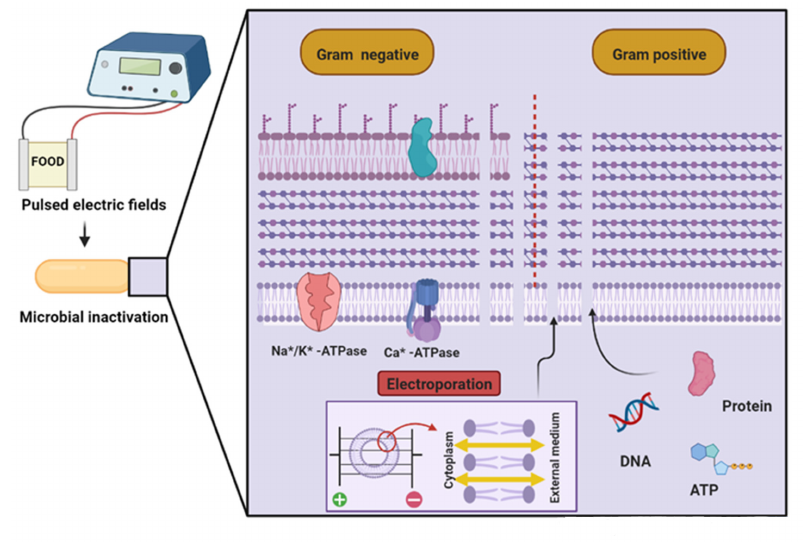
Figure 2. Mechanisms of microbial inactivation by pulsed electric fields [66] (Created with BioRender. com; accessed on 30 March 2022). DNA: Deoxyribonucleic acid, ATP: Adenosine